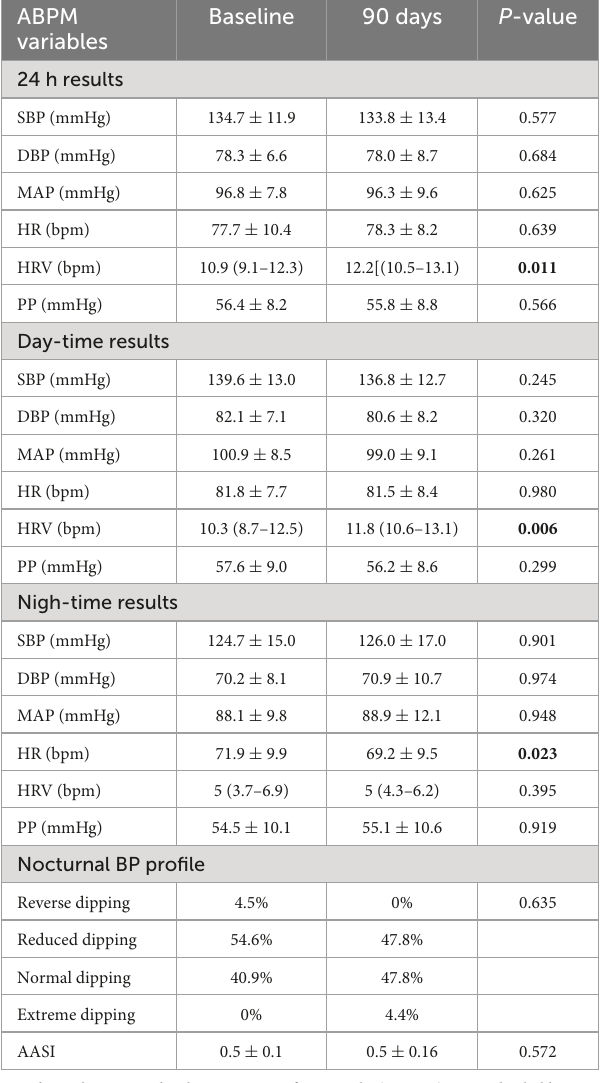
TABLE 1 Ambulatory blood pressure monitoring (ABPM) data at baseline and at the end of the study. ABPM